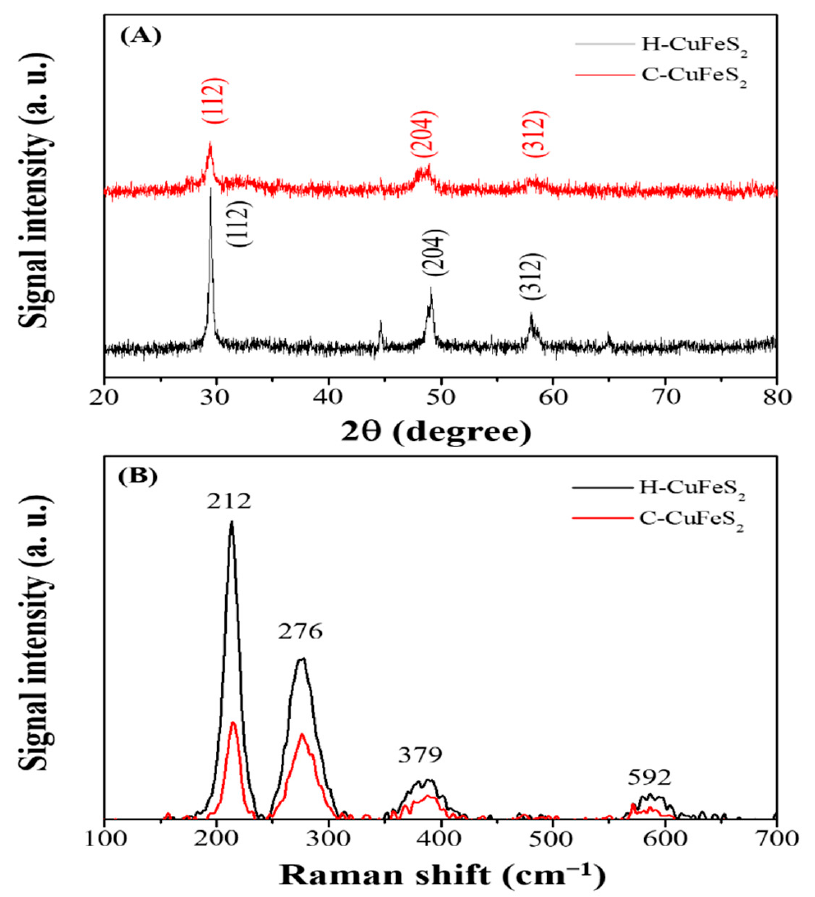
Figure 4. ( A ) XRD and ( B ) Raman spectra of H-CuFeS 2 (black), and C-CuFeS 2 (red) samples. As another quality assurance method, XPS analysis of the prepared CuFeS 2 samples (Figures 5 and 6) revealed that it contains three elements: Cu, Fe, and S [48,49]. High- resolution XPS revealed Cu2p, Fe2p, and S2p in the H-CuFeS 2 samples as shown in Figure 5B–D, respectively. In Figure 5B, the peaks at 931.9 and 951.7 eV correspond to Cu + 2p 3/2 and Cu + 2p 1/2 , respectively, whereas those at 933.2 and 953.0 eV correspond to Cu 2+ 2p 3/2 and Cu 2+ 2p 1/2 , respectively. The peaks at 711.7 and 724.9 eV correspond to Fe 2+ 2p 3/2 and Fe 2+ 2p 1/2 , respectively, whereas those at 715.2 and 734.3 eV correspond to Fe 3+ 2p 3/2 and Fe 3+ 2p 1/2 , respectively (Figure 5C). The peaks at 162.5 and 167.8 eV correspond to S 2 − 2p and S 6+ 2p, respectively (Figure 5D). For C-CuFeS 2 samples, the peaks at 931.9 and 951.6 eV correspond to Cu + 2p 3/2 and Cu + 2p 1/2 , respectively, whereas those at 934.1 and 952.7 eV correspond to Cu 2+ 2p 3/2 and Cu 2+ 2p 1/2 , respectively (Figure 6B). The peaks at 711.4 and 724.8 eV correspond to Fe 2+ 2p 3/2 and Fe 2+ 2p 1/2 , respectively, whereas those at 714.6 and 734.2 eV correspond to Fe 3+ 2p 3/2 and Fe 3+ 2p 1/2 , respectively (Figure 6C). The peaks at 162.5 and 168.9 eV correspond to S 2 − 2p and S 6+ 2p, respectively (Figure 6D). According to its peak area, the percentage of different oxidation states of each element in the prepared CuFeS 2 samples can be estimated. In H-CuFeS 2 samples, elemental com- positions were found 82.3% Cu + and 17.6% Cu 2+ from Cu analysis, 66.9% Fe 2+ and 33.1% Fe 3+ from Fe analysis, and 74.2% S 2 − and 25.7% S 6+ from sulfur analysis. In C-CuFeS 2 samples, elemental composition was found to be 90.6% Cu + vs. 9.3% Cu 2+ for Cu, 60.8% Fe 2+ vs. 39.2% Fe 3+ for Fe, and 62.6% S 2 − vs. 37.3%. S 6+ for